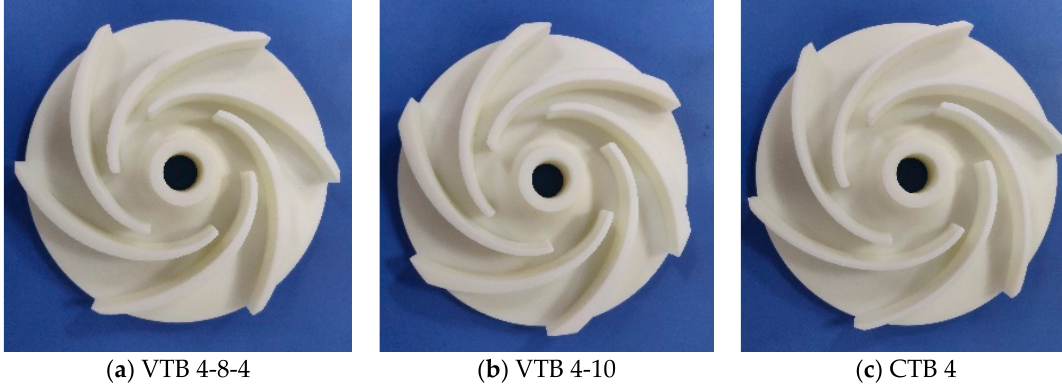
Figure 15. Test impelle.